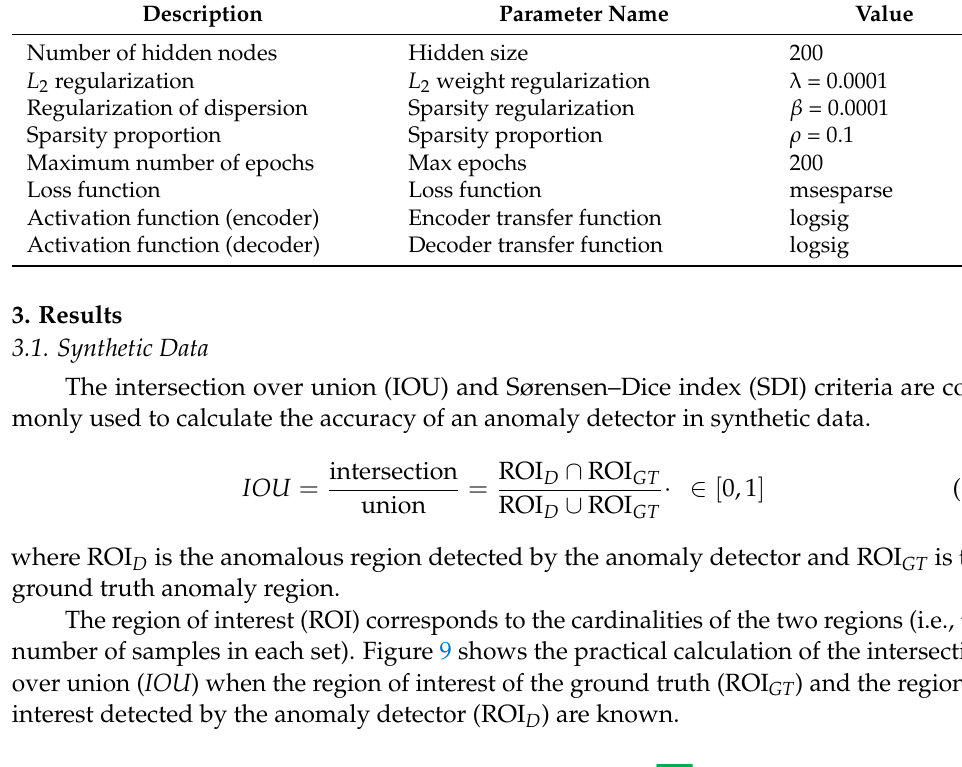
Table 7. Training parameters for the autoencoder detector.